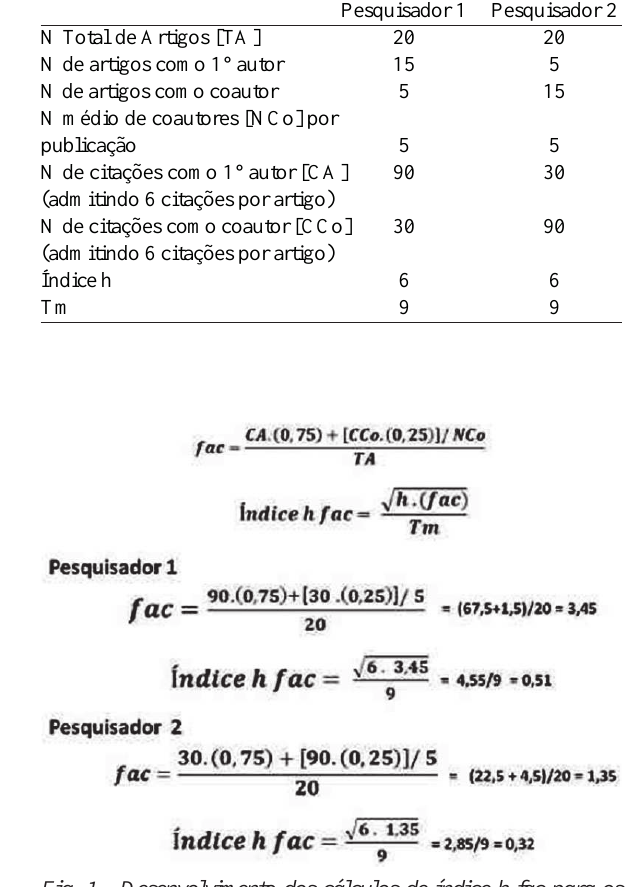
Fig. 1 - Desenvolvimento dos cálculos de índice h-fac para os pesquisadores 1 e